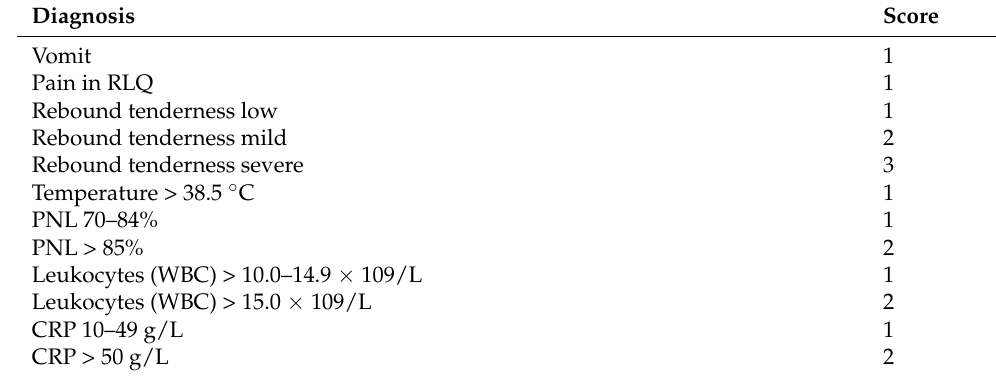
Table 1. Appendicitis Inflammatory Response (AIR)